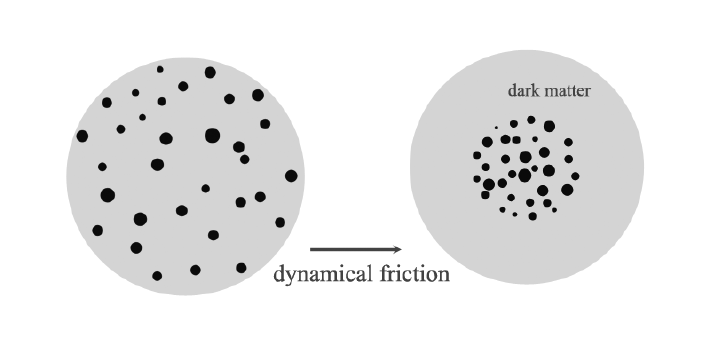
Figure 2. A compact primordial black hole (PBH) subsystem is formed inside the object under the influence of dynamical